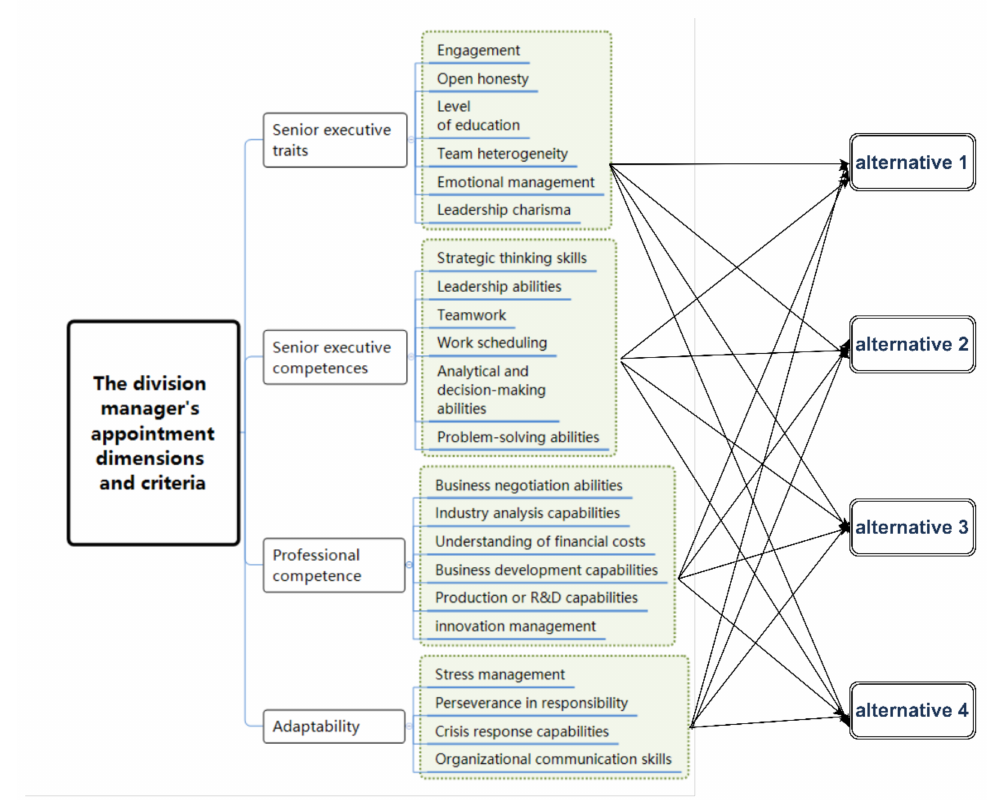
Figure 3. Research